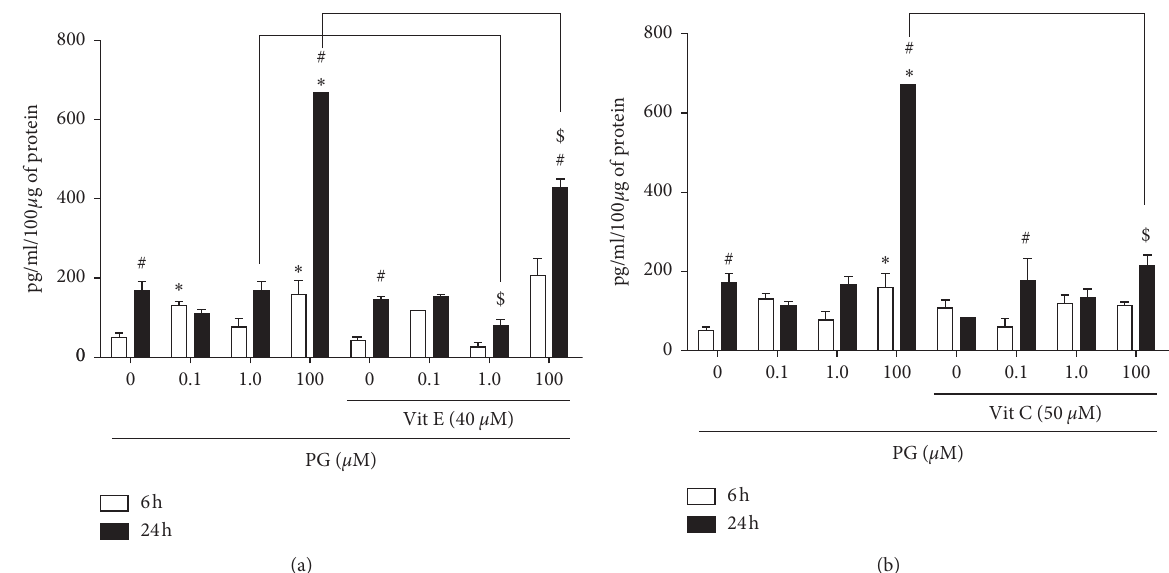
Figure 7: Hmox1 content in progesterone-treated RINm5Fcells. Cells were preincubated with 40 μ M vitamin E (a) or 50 μ M vitamin C (b) for 2h, and then with 0.1, 1.0, or 100 μ M progesterone for 6 or 24h. Data are presented as means ± SEM of three experiments in duplicates. ∗ indicates difference compared to control. # indicates difference between the incubation time points, for the same progesterone con- centration. $ indicates difference in comparison to the treatment without antioxidants ( ρ < 0.05). PG: progesterone; Vit E: vitamin E; Vit C: vitamin